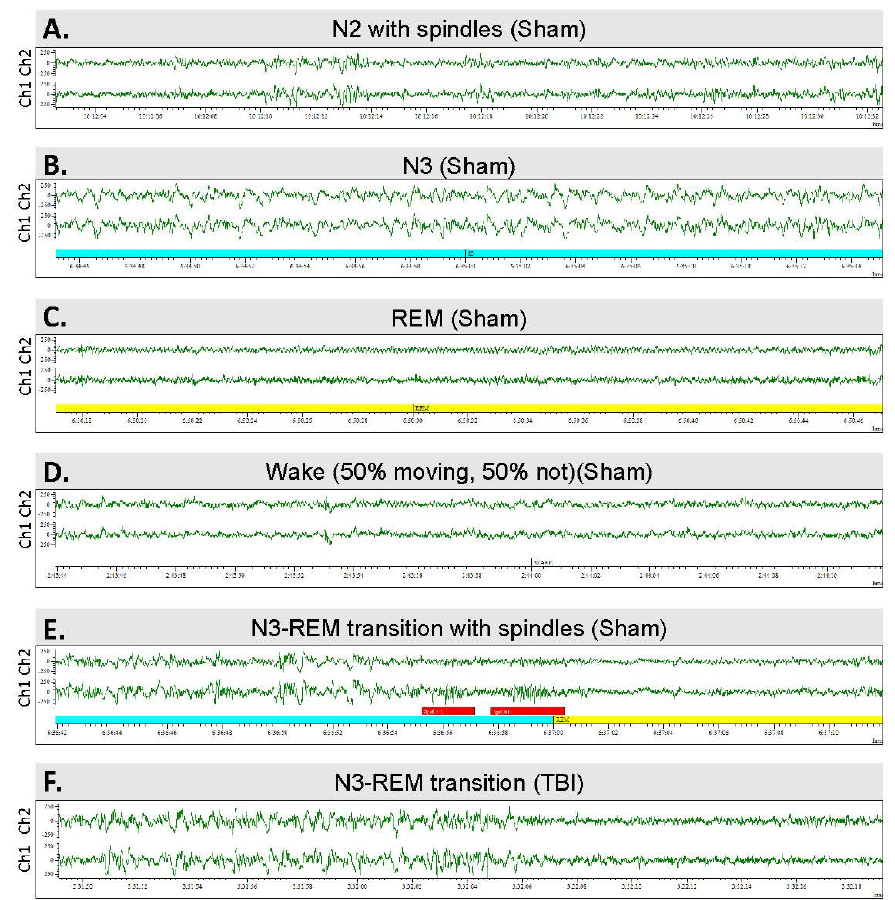
Figure 5. Sleep architecture—the sleep–wake stages analyzed: ( A ) Stage N2 sleep with spindles. ( B ) Stage N3. ( C ) Rapid eye movement (REM) sleep. ( D ) Waking EEG. ( E ) N3–REM transition sleep period in a sham-operated rat. Note the K-complexes and sleep spindles (red bars). ( F ) N3–REM transition sleep period in a rat with traumatic brain injury and post-traumatic